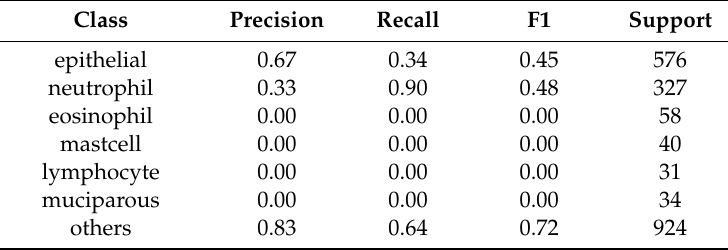
Table 6. Evaluation metrics—classification on CELLS-CYT